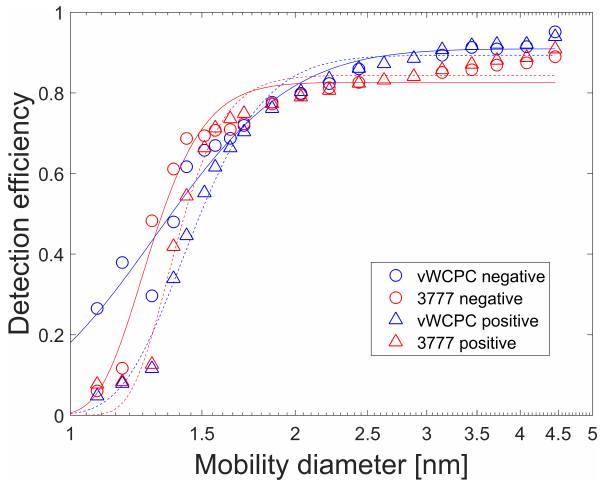
Figure 6. Detection efficiency of the CPCs as a function of size for positively and negatively charged tungsten oxide particles at high dT settings.